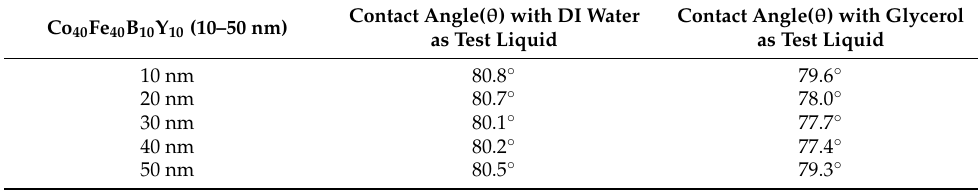
Table 3. Average contact angles of CoFeBY thin films at RT with DI water and